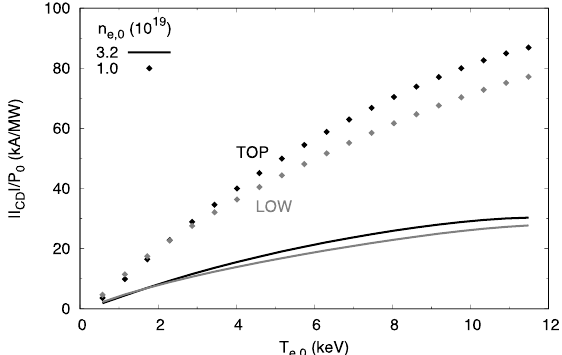
Fig. 11. Driven current as a function of T e,0 for different n e scaling (n e,0 in m -3